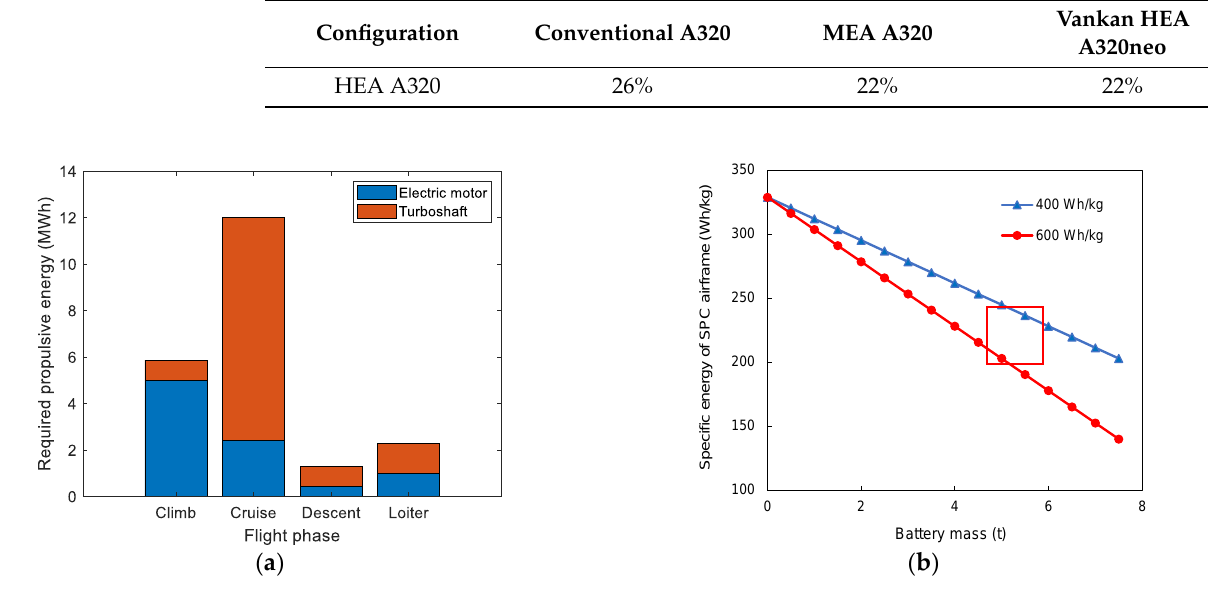
Figure 11. ( a ) HEA propulsive energy split. ( b ) SPC performance requirements for HEA with an SPC airframe together with 400 Wh/kg and 600 Wh/kg batteries.